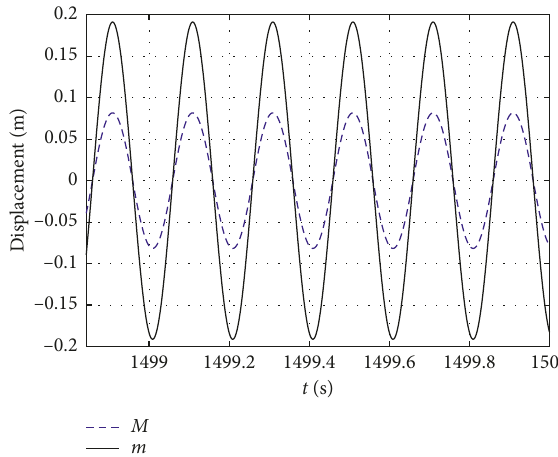
Figure 13: Displacement time history curves of shell and oscillator in period